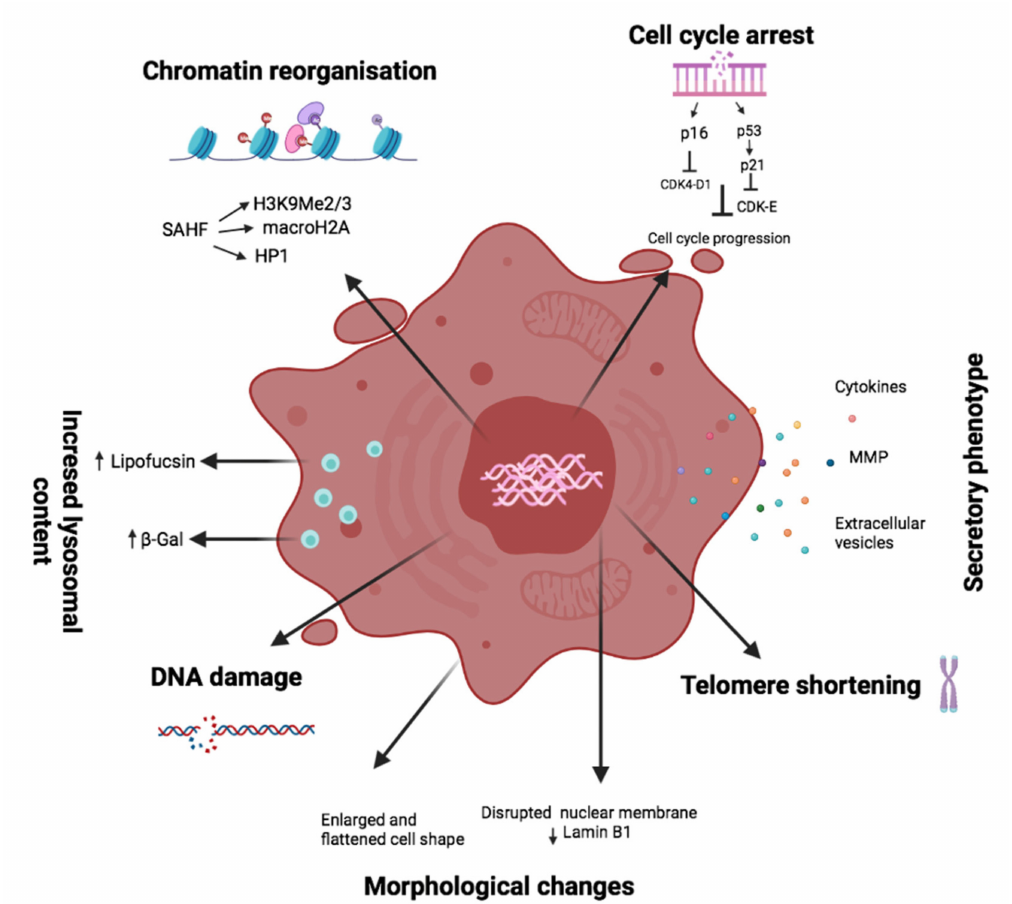
Figure 1. Hallmarks of cellular senescence. A large number of cellular processes are involved in the development of senescence. These include: morphological changes and macromolecular damage; increased lysosomal compartment, which is characterized by the overexpression of β -Gal; chromatin reorganization, which includes senescence-associated heterochromatin foci (SAHF); irreversible cell cycle arrest, driven by the action of p16 and p21/p53 axes, depending on the senescence driver and the implementation of a secretory phenotype, known as senescent-associated secretory phenotype (SASP) and characterized by the release of matrix metalloproteinases (MMP), cytokines and extracellular vesicles. Although these markers are strongly associated with a senescent phenotype, they are not exclusive or essential for the development of the program (with the exception of cell cycle